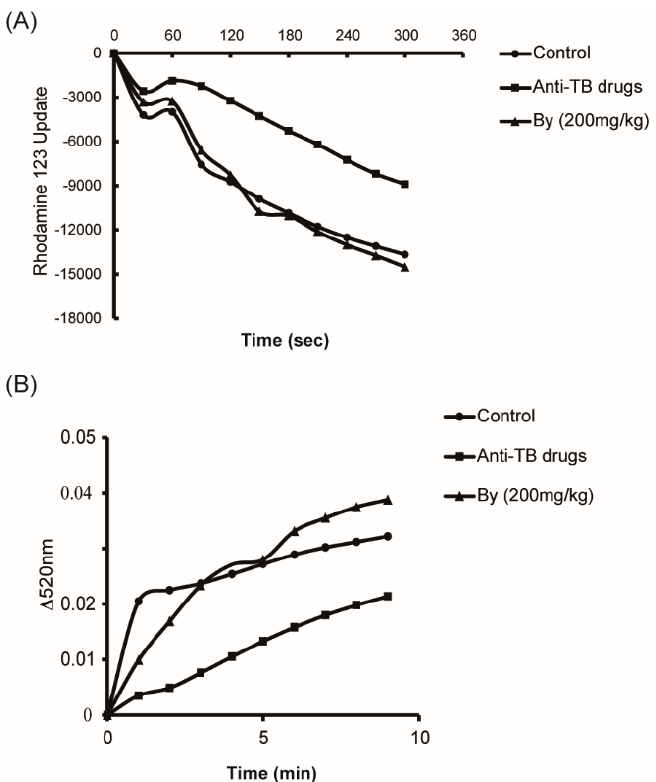
Figure 6. Effect of bicyclol on liver mitochondrial permeability transition (MPT) in anti-TB drug intoxicated rats. Bicyclol (200 mg/kg) was administered orally to rats for 30 days. Mitochondria were isolated immediately after the livers were dissected. ( A ) Mitochondrial membrane potential. ( B ) Mitochondrial swelling.